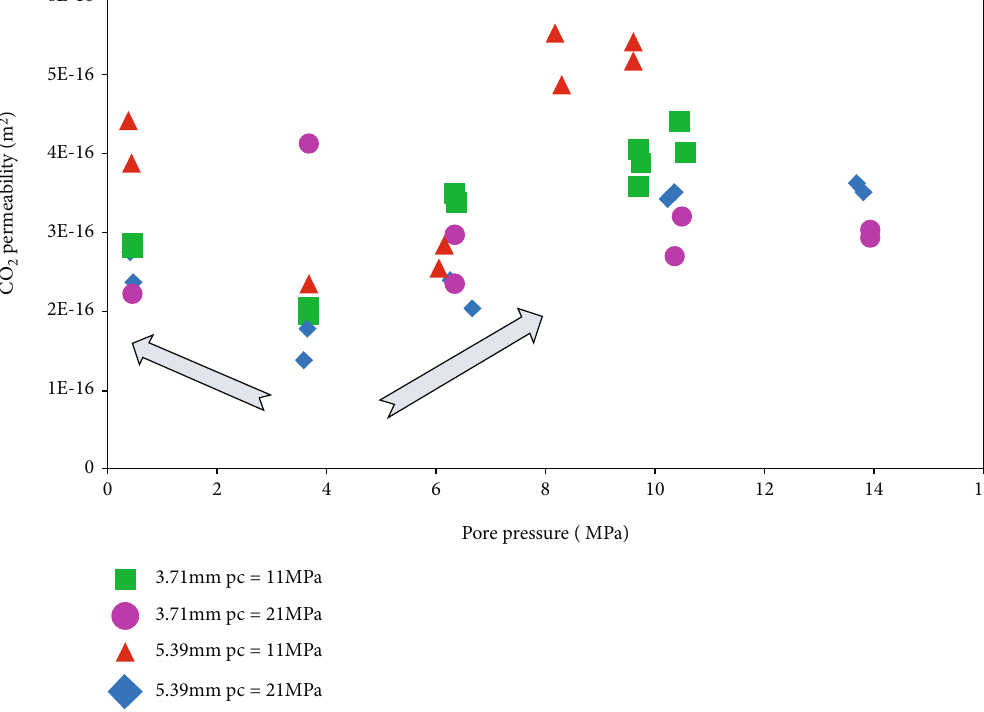
Figure 7: Permeability data with CO injection on shale thin disks (3.71mm and 5.39mm) under 11 and 21 MPa con fi ning (hydrostatic) 2 pressure, processed by using Cui et al. ’ s